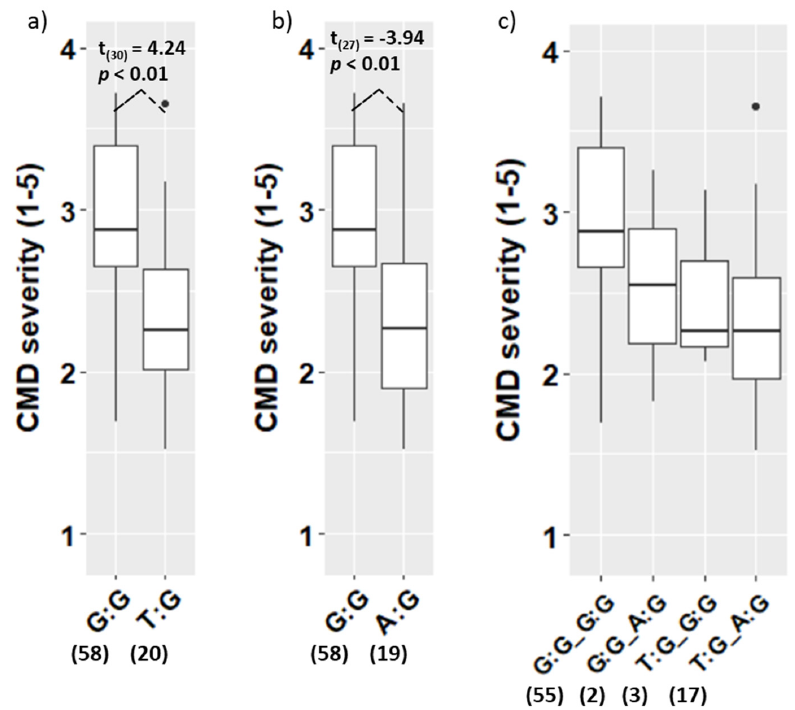
Figure 6. The CMD severity of the VNM142 population grouped by the genotype of the CMD markers S12_7926132 and S14_4626854. ( a ) The CMD severity of the different genotypes at 10 months after planting. Among the 78 clones in VNM142, 20 clones had the resistant allele T of S12_7926132. Significant difference among the genotypes with and without the resistant allele was observed (the mean of the CMD severity scores 2.3 vs. 2.9). ( b ) Significant difference among the genotypes with and without the resistant allele A of S14_4626854 was observed (the mean of the CMD severity scores 2.3 vs. 2.9). ( c ) The combination effect of the two markers. S12_7926132 and S14_4626854 co-segregated in 72 of the 77 clones (94%). Marker S12_7926132 explained an 11% variation in the population VNM142, and S14_4626854 accounted for 8%. When considering both markers, we observed that only 11% variation was explained, which indicated the strong interaction between the two markers. In this diverse VNM142 population, we found a high rate of co-segregation between the two markers. Among the 77 clones with the genotypic data of both markers, 72 clones (94%) had the same genotype for both markers (Figure 6c). The high rate of co- segregation between the two loci on different chromosomes seems abnormal, and the high rate of co-segregation (73%) was also observed in the CIAT102 population (Figure 5b). 4. Discussion 4.1. CMD Resistance in the Introduced Germplasm from the CIAT and Asian Landraces The introduced population, CIAT102, was derived from CMD2 donors, C-clones, which were the progeny of the CMD-resistant clones in Africa, TME3 [16]. The CMD2 resistance was confirmed in the CIAT102 clones because 34 clones were asymptomatic when exposed to the SLCMV. The siblings of the CIAT102 clones had been evaluated in Africa, and CR36-5, released as Ayaya, had good CMD resistance and high and stable dry matter (CGIAR news). Even though the family CR36 was not present in the CIAT102 population, we expect that some CIAT102 clones might have good agronomic performance and can be released as the first generation CMD-resistant varieties in SEA. Moreover, CR24-4, CR43-7, and CR43-2, introduced from CIAT, were released in India